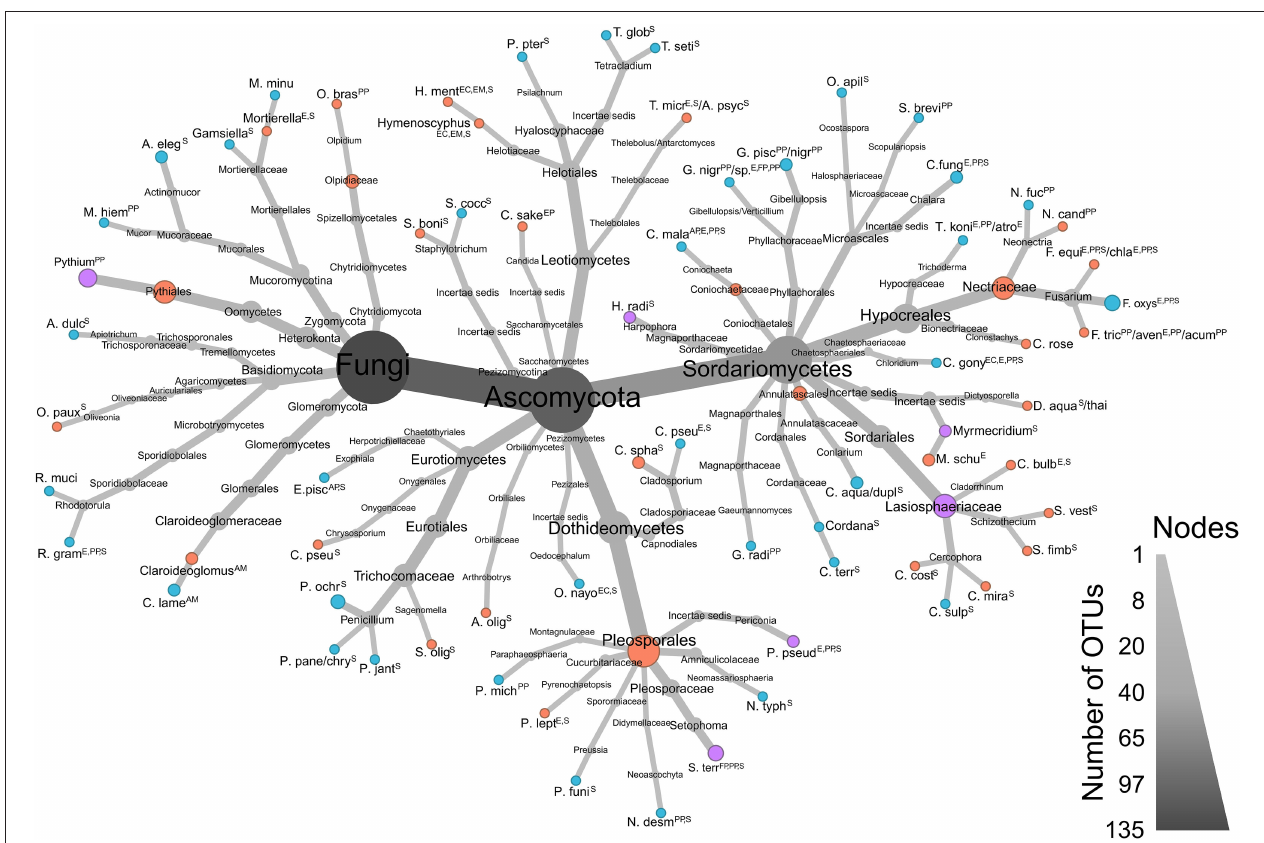
FIGURE 6 | Taxonomy heatmap of significant ALDEx OTUs of ecological importance found in low (red) and high (blue) productivity sites, or in both (purple). Sizes of each node are proportionate to the number of OTUs in each branch. Data from all 4 primer sets (LSUA, LSUBG, ITS2-F, and V4AM) were combined. Ecological guilds for each taxon determined by FUNGuild ( Nguyen et al., 2016): AM, Arbuscular mycorrhizal; AP, Animal pathogen; E, Endophyte; EC, Ectomycorrhizal; EM, Endomycorrhizal; EP, Epiphyte; IP, Insect parasite; FP, Fungal pathogen; PP, Plant pathogen; S, Saprotroph. Note: “animal pathogen” not kept for opportunistic animal pathogens; “lichen parasite” deleted; “bryophyte parasite” deleted; “ericoid mycorrhizal” deleted; “orchid mycorrhizal” deleted; “soil saprotroph,” “plant saprotroph” and “wood saprotroph” combined to